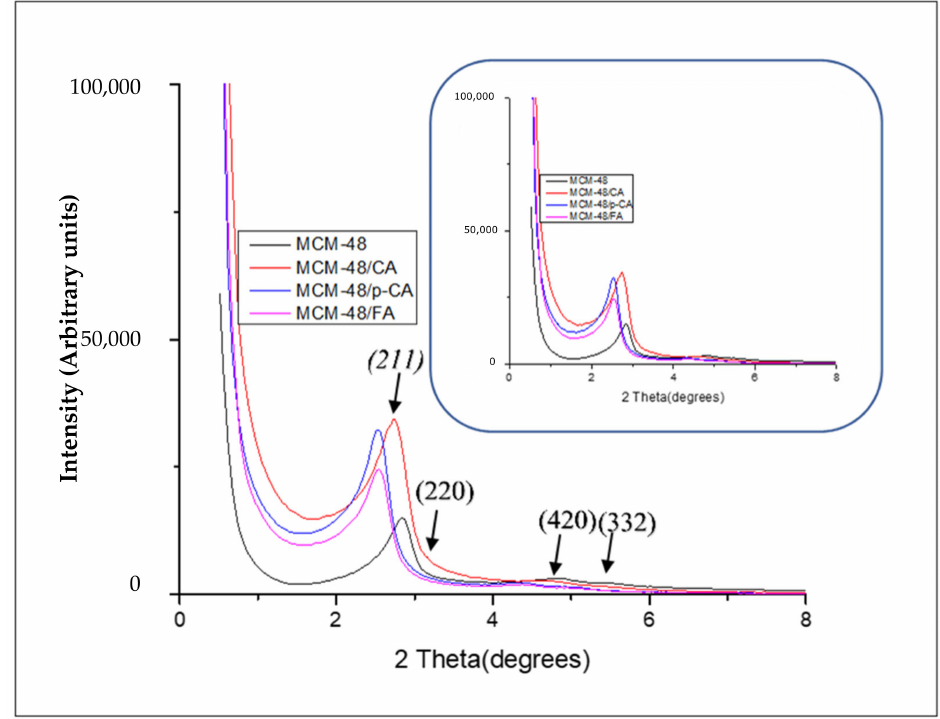
Figure 3. XRD diffractograms of samples MCM-48, MCM-48/CA, MCM-48/p-CA and MCM-48/FA. All MCM-41 samples loaded with polyphenols showed type IV isotherms show- ing a hysteresis loop of type H1, characteristic for MCM-41-type mesoporous